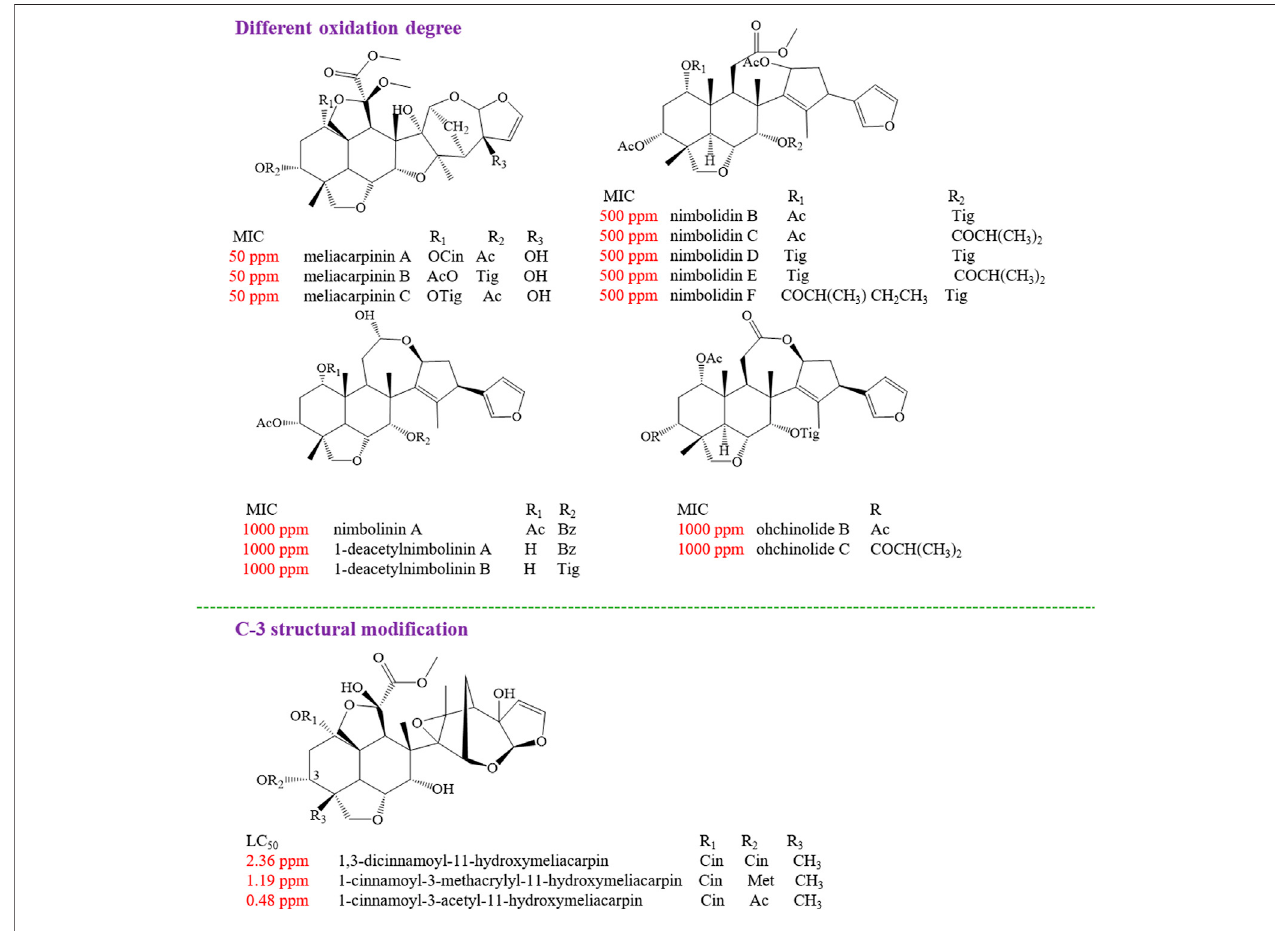
FIGURE 11 | The insecticidal structure – activity relationship of limonoids